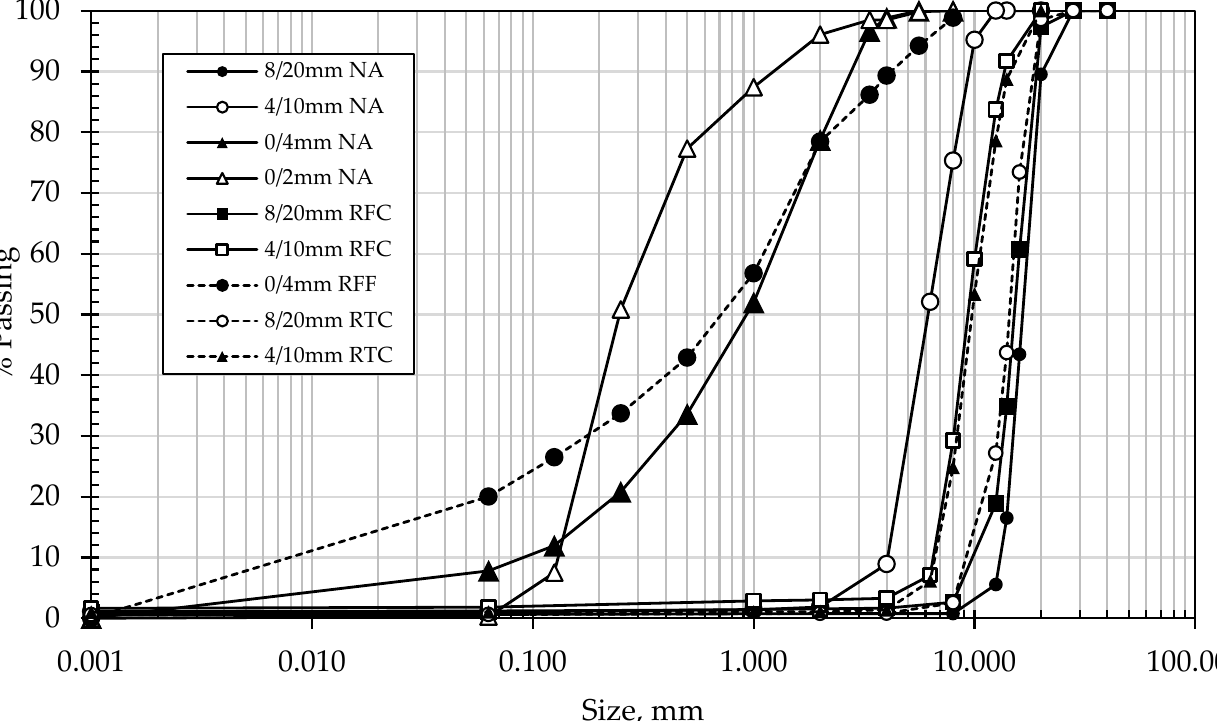
Table 1. Properties of aggregates.